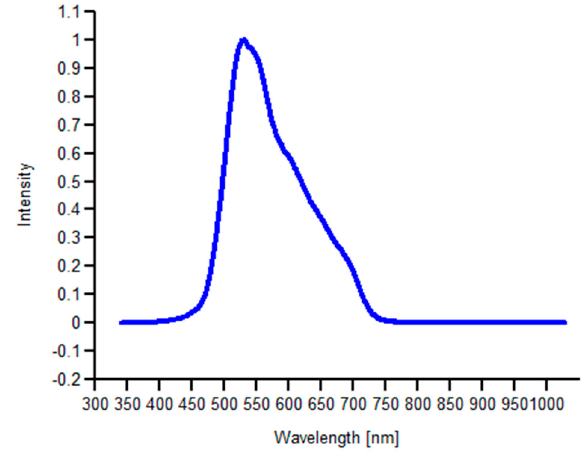
Figure 1. Reflectance spectrum of photonic crystal particles of colloidal silica nanoparticles .